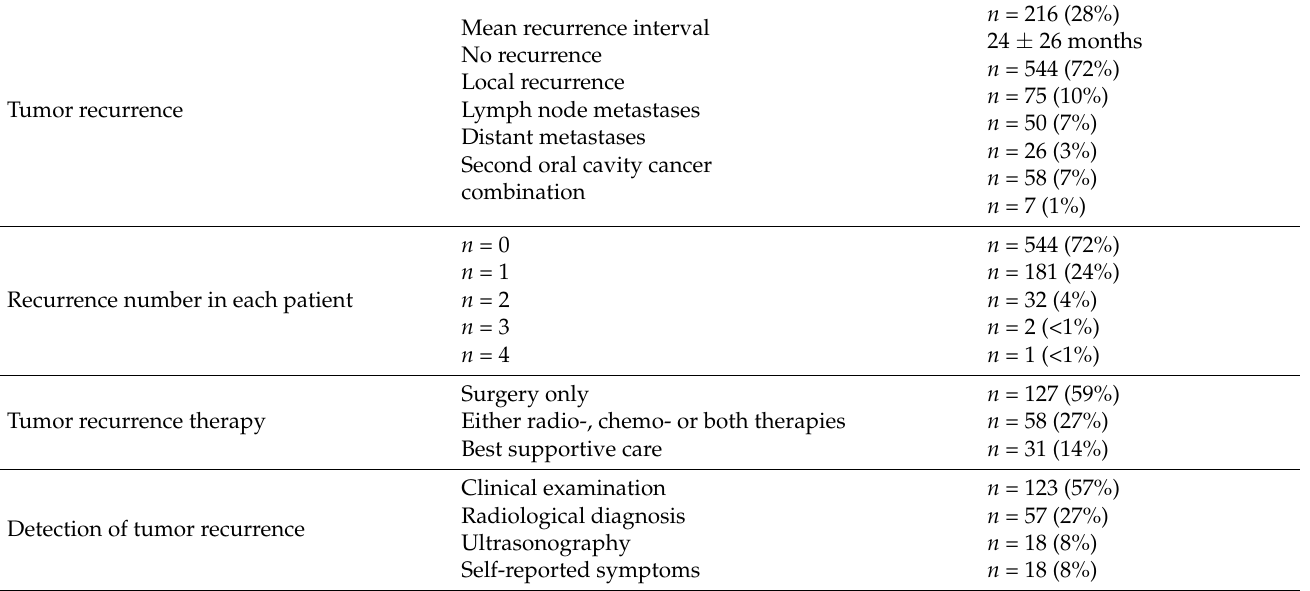
Table 2. Epidemiological data of recurrence cases ( n =